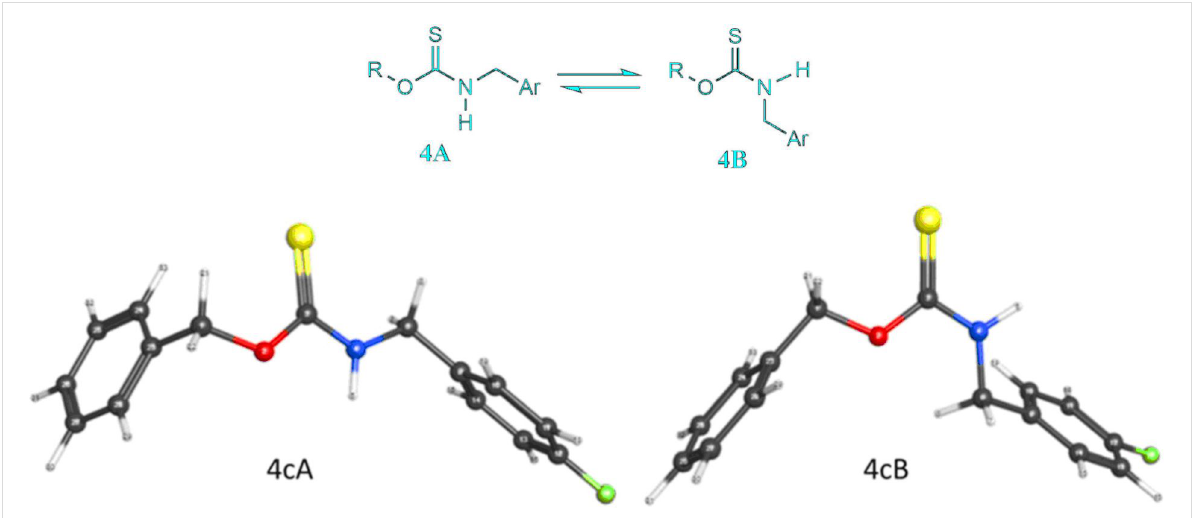
Figure 3: Rotamers of thionocarbamates 4 (top) and computer-minimized structures of 4c (bottom).